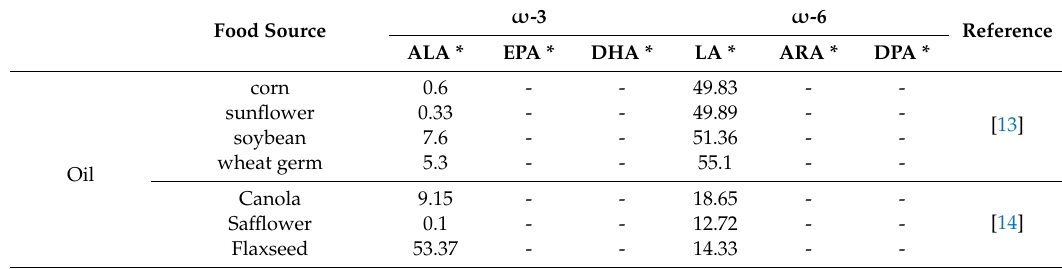
Table 1. Contents of ω -3 and ω -6 fatty acids in selected plant and animal-based